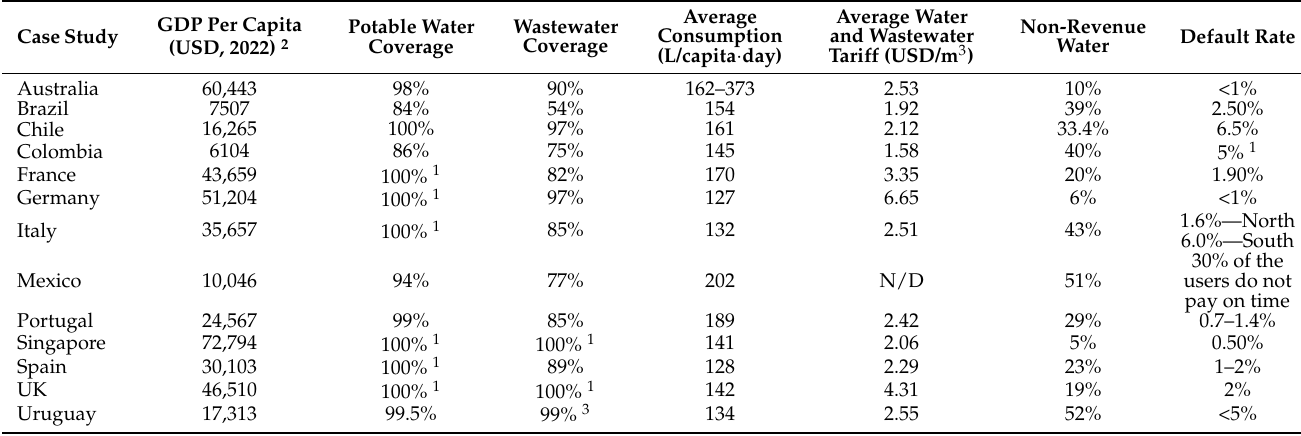
Table 1. Case study main